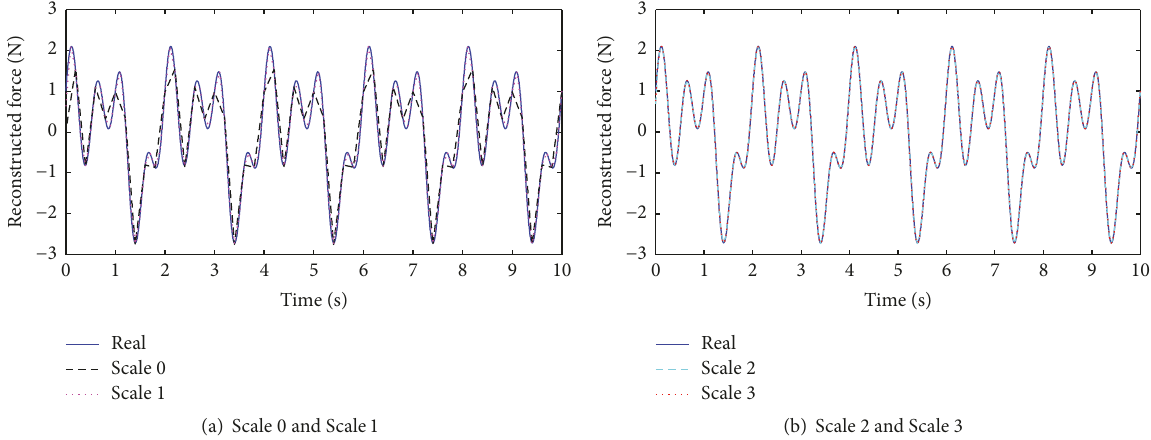
Figure 5: The reconstructed dynamic force in Case B1.